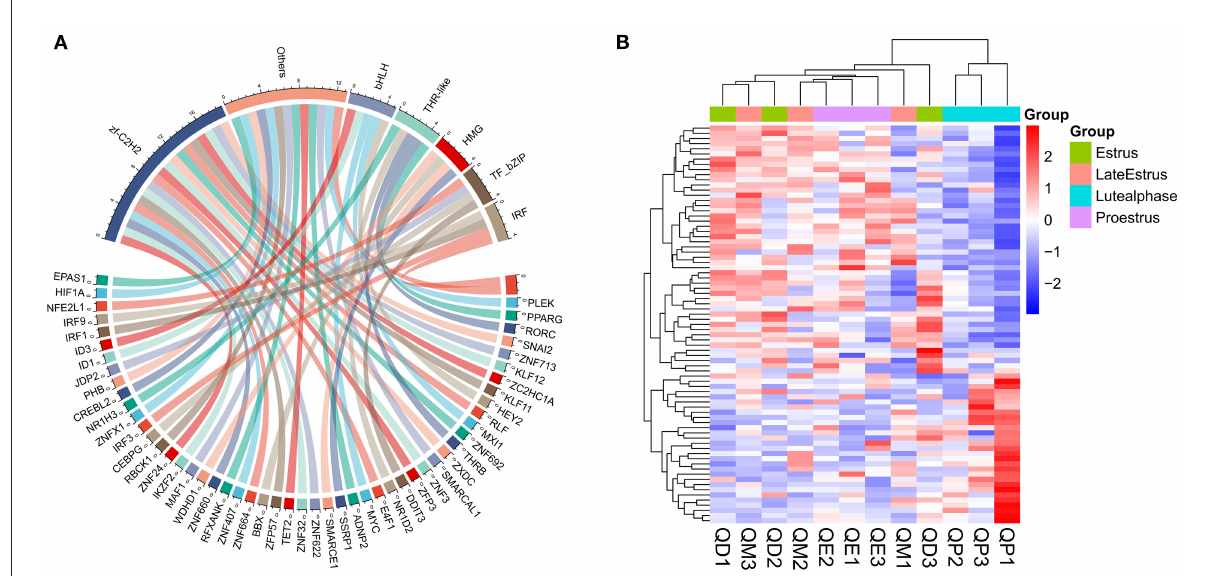
FIGURE12 TF family statistics and heatmap analysis in black and yellow modules. (A) TF prediction and family statistics of three modules. (B) Heatmap of TFs in three modules. Red and Blue represent up- and down-regulated DEmRNAs,